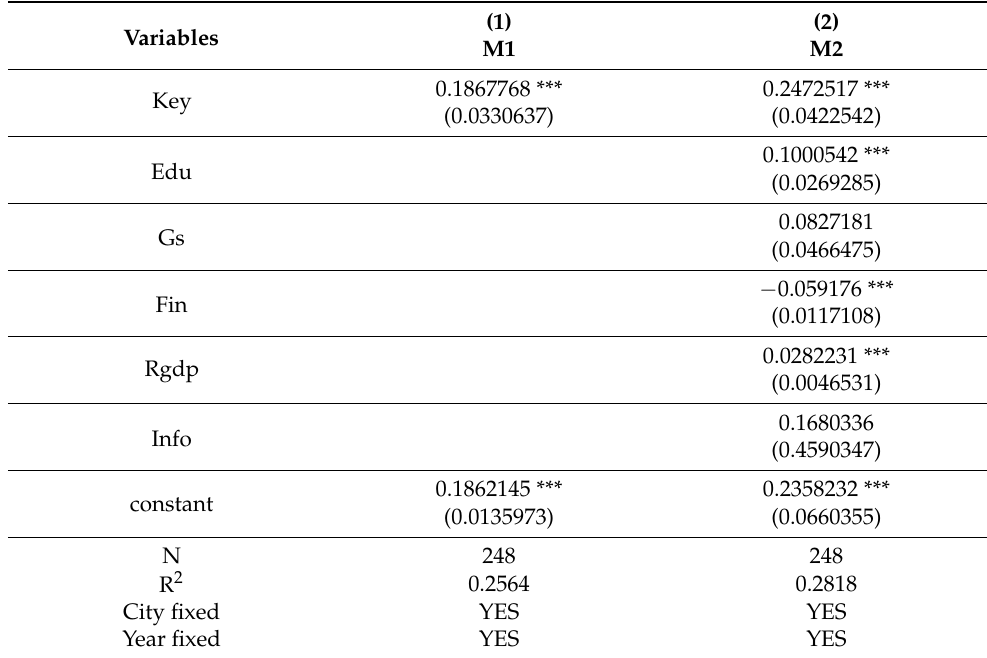
Table 2. Results of baseline